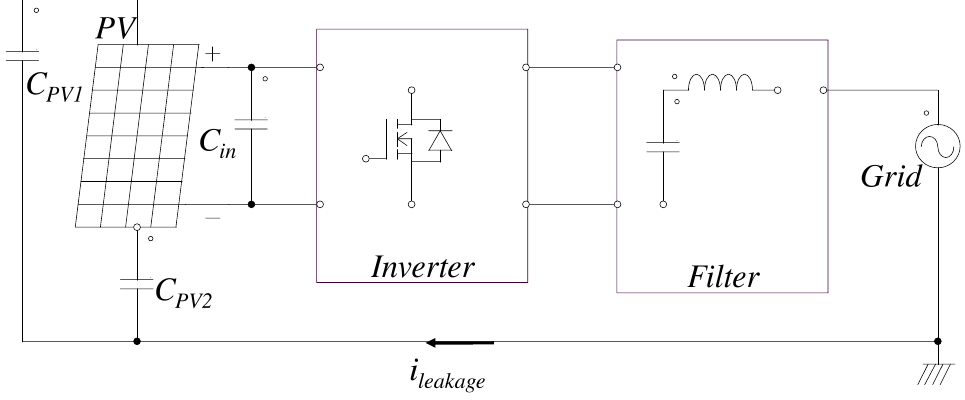
Figure 3. General scheme grid-connected transformerless VSI